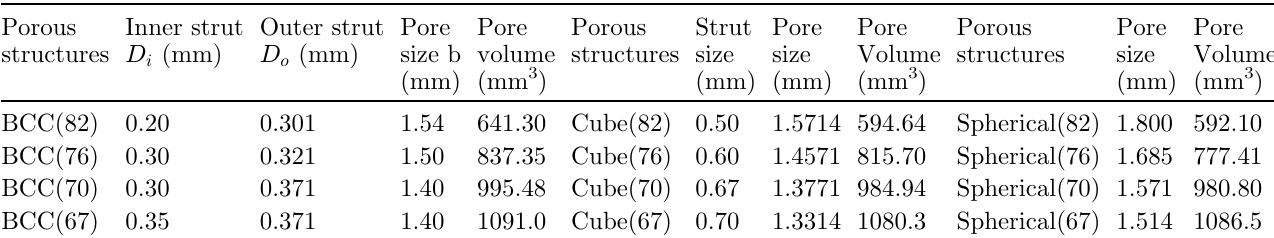
Table 1. The dimensions of individual components of the BCC, Cubic, and Spherical porous structures. Porous Inner strut D structures i